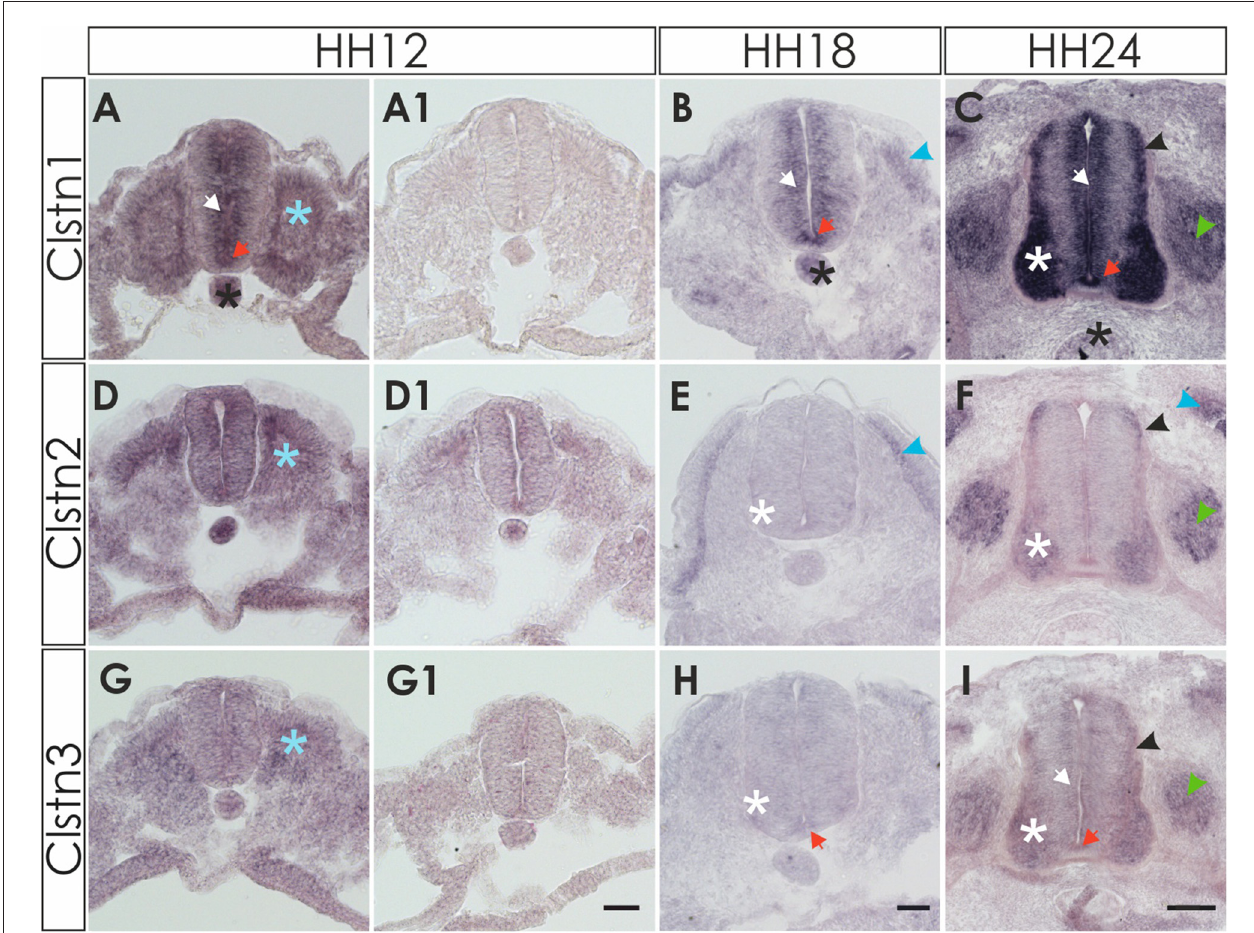
FIGURE 1 | Expression of calsyntenins in early spinal cord development (HH12-HH24). (A–C) Calsyntenin-1 (Clstn1) mRNA was found in the ventricular zone (VZ; white arrow) and in the floor plate (orange arrow) already by HH12. Expression was also seen in the notochord (black asterisk) and in somites (blue asterisk; A ). No staining was detected in an adjacent section processed with the sense probe (A1) . At HH18 (B) , Clstn1 is still expressed in the VZ (white arrow). The signal in the floor plate was now more distinct (orange arrow). Expression persisted in the notochord (black astersik) and was also observed in the dermamyotome (blue arrowhead). At HH24 (C) , Clstn1 mRNA expression is maintained in the VZ (white arrow) and in the floor plate (orange arrow). Highest levels were found in motoneurons (white asterisk). Expression was also found in interneurons all along the dorso-ventral axis (black arrowhead) and in dorsal root ganglia (DRG; green arrowhead). Expression in the notochord decreases with age (black asterisk). (D–F) Clstn2 mRNA was found at very low levels, if at all, in the neural tube after its closure. Note that the background in the section processed with the sense probe (D1) is relatively high for the youngest stage. At HH12, expression was detected